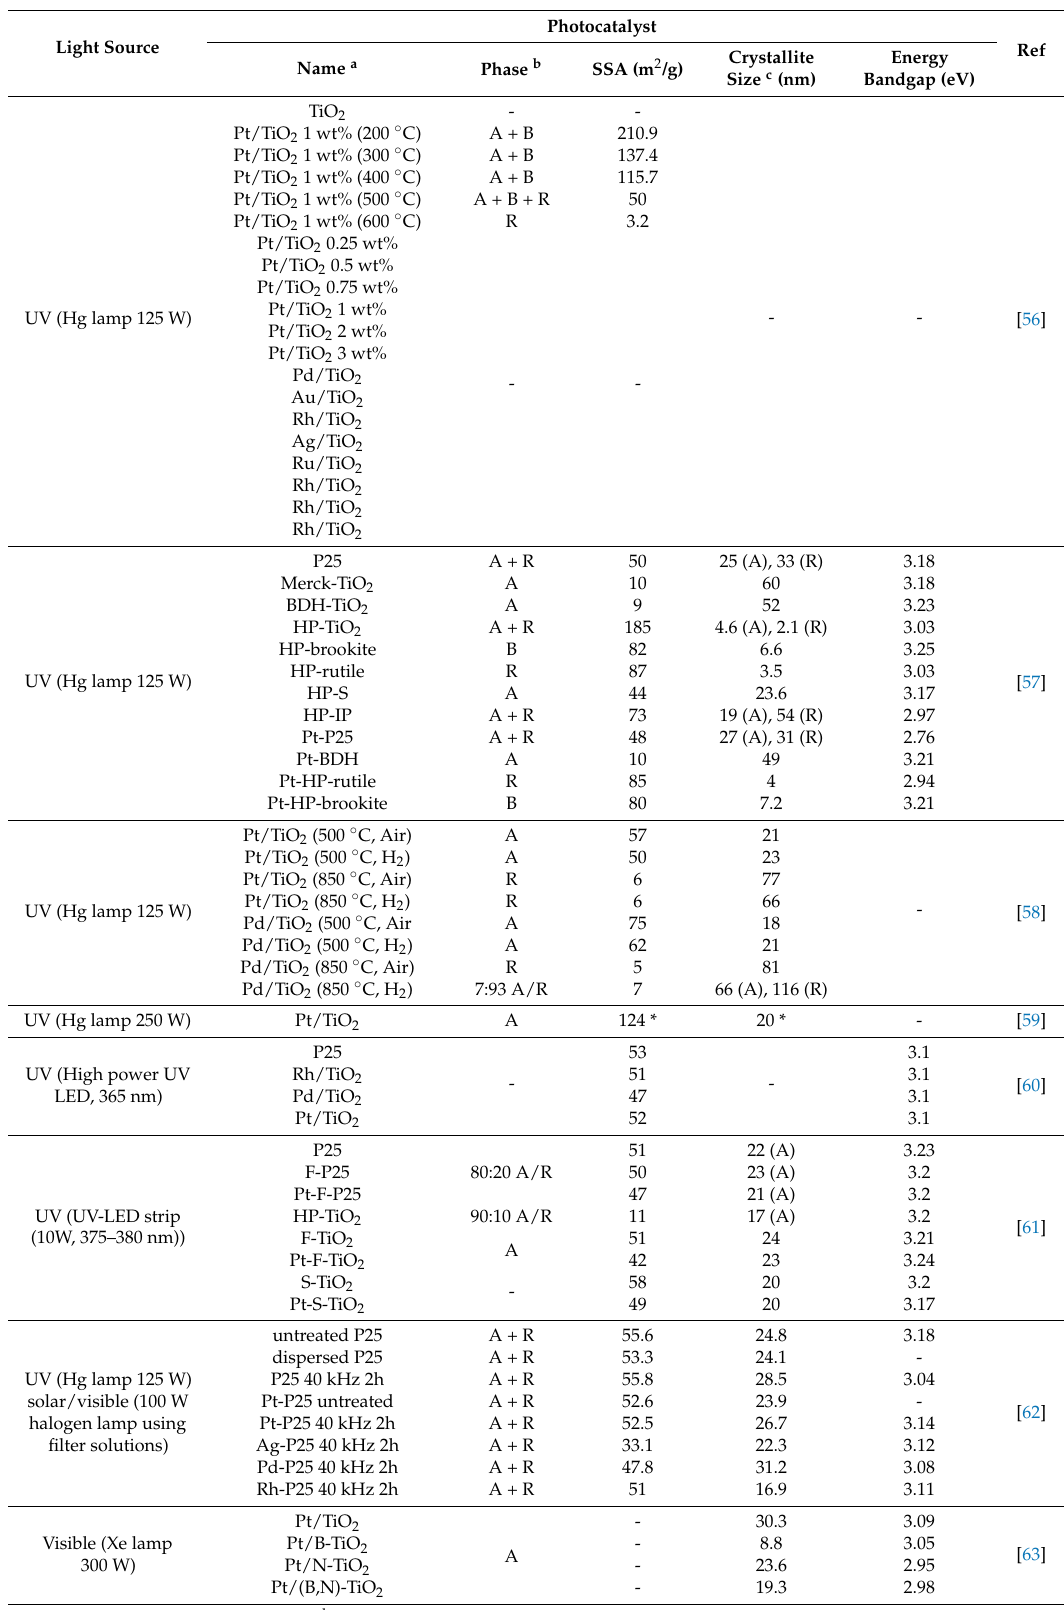
Table 8. TiO 2 -based catalysts used for H 2 -production from